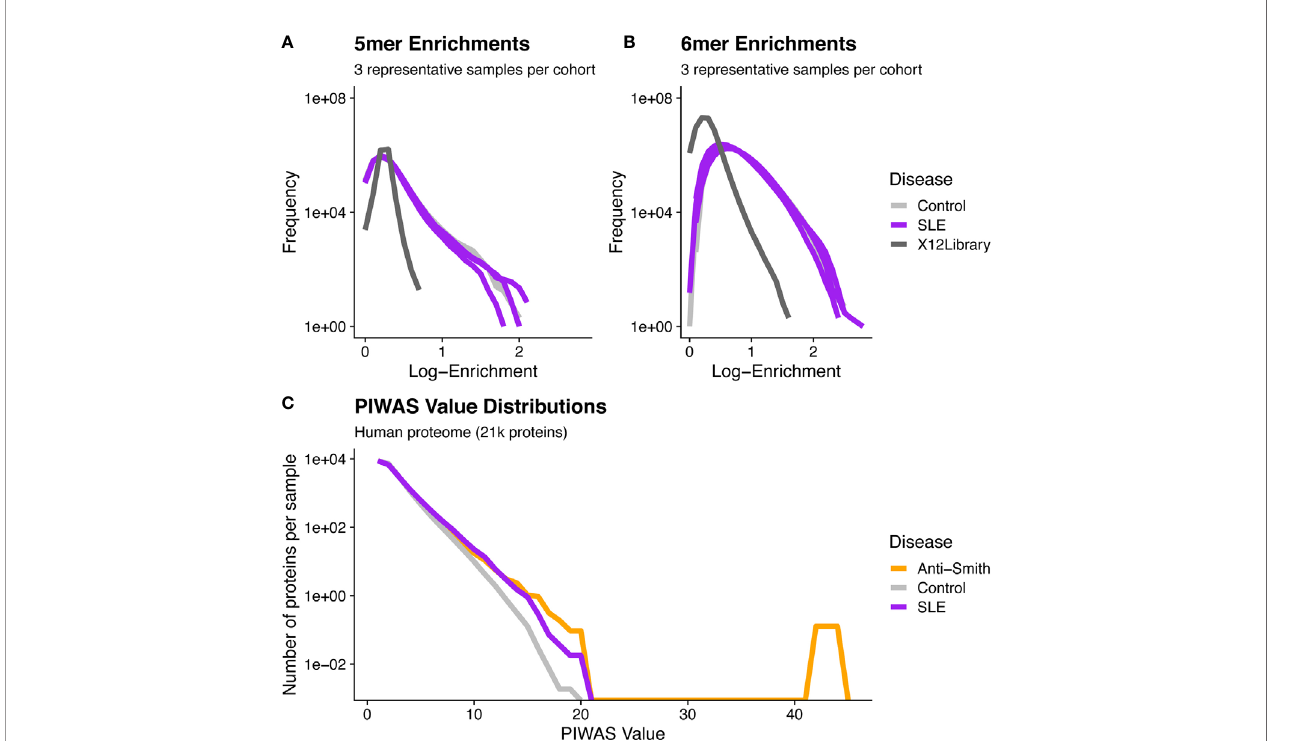
FIGURE 2 | Distributional differences in kmer enrichments and PIWAS values between the unselected library and after selecting with SLE and control specimens. 5mer (A) and 6mer (B) Kmer frequency (y-axis) vs. Log-enrichment score (x-axis) for 6 subjects and the naïve library demonstrates species with large enrichments are found exclusively in those SERA assays incubated with serum. All 5mers or 6mers from three representative samples per cohort are evaluated for enrichment. Dark-gray lines = naïve 12-mer peptide library, purple lines = SLE cohort, gray lines = control cohort. (C) A comparison of PIWAS values (x-axis) vs. the number of proteins per sample with the corresponding PIWAS value (y-axis) reveals differences in both the range and distribution of PIWAS values between SLE and control samples. Distributions are based on 31 SLE cases and 1,157 controls. Purple = SLE cohort, gray = control cohort, orange = anti-Smith